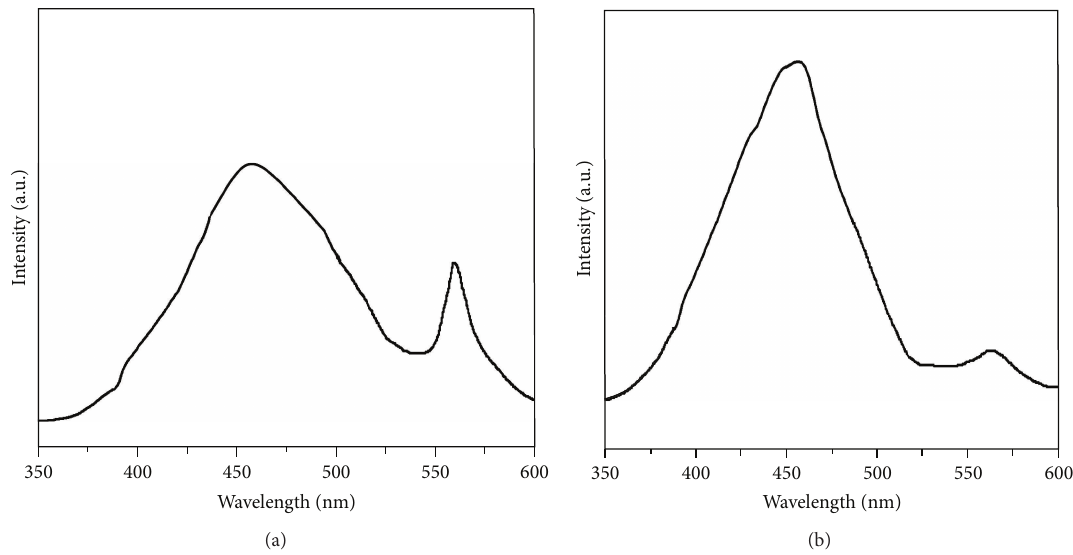
Figure 10: PL spectra of (a) as-prepared and (b) 700 ∘ C heated nano-BaWO 4